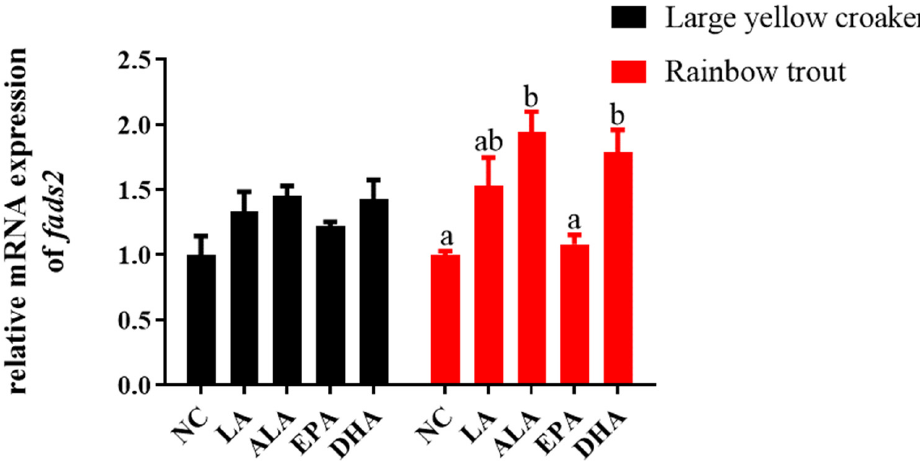
Figure 2. The relative expression of fads2 in hepatocytes of large yellow croaker and rainbow trout. The hepatocytes were in response to different fatty acids incubation of 100 µ M concentration for 12 h. Values are presented as mean ± SEM ( n = 3). NC: negative control, LA: linoleic acid, ALA: α -linolenic acid, EPA: eicosapentaenoic acid, DHA: docosahexaenoic acid. Bars without sharing a common letter are significantly different ( p <